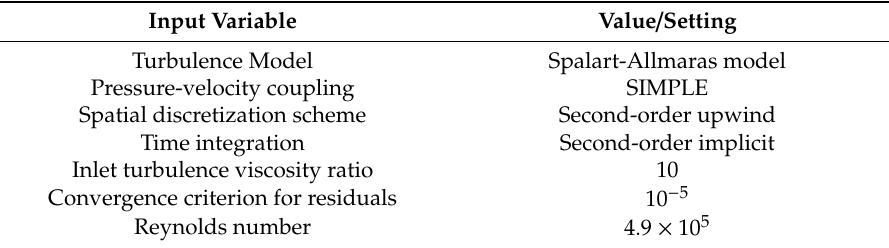
Figure 8. Aerodynamic loads acting on di ff erent VAWT blades in X- and Y-directions: ( a ) H-type VAWT in the X-direction; ( b ) H-type VAWT in the Y-direction; ( c ) hybrid VAWT in the X-direction; and ( d ) hybrid VAWT in the Y-direction. Table 2. Summary of parameters in CFD